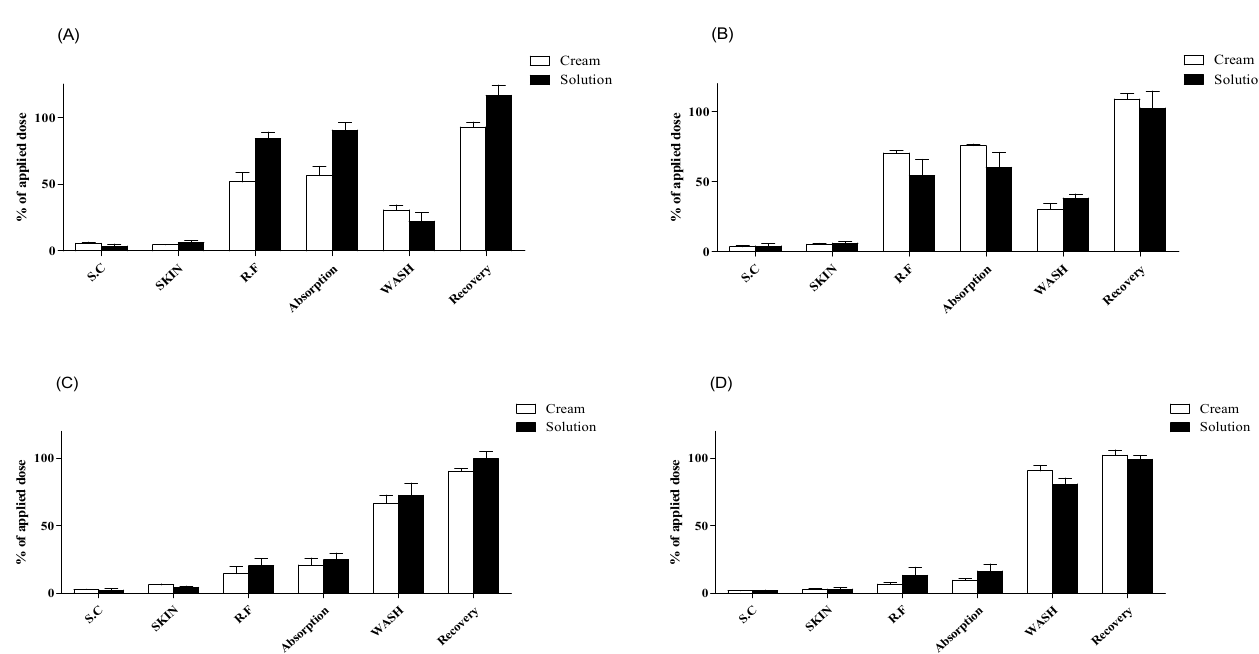
Figure 2. Dermal absorption of caffeine in Micropig ® skins ( n = 4, mean ± SD). Dermal absorption test results with doses of ( A ) 5 mg/cm 2 or 5 µ L/cm 2 , ( B ) 10 mg/cm 2 or 10 µ L/cm 2 , ( C ) 25 mg/cm 2 or 25 µ L/cm 2 , and ( D ) 50 mg/cm 2 or 50 µ L/cm 2 . SC, stratum corneum; SKIN, dermis and epidermis; RF, receptor fluid; WASH, remaining formulation rinsed using alcohol swabs.